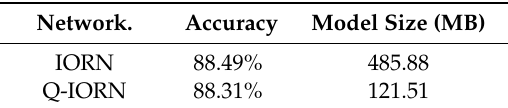
Table 1. The classification accuracy of the proposed quantized improved oriented response network (Q-IORN) and baseline.